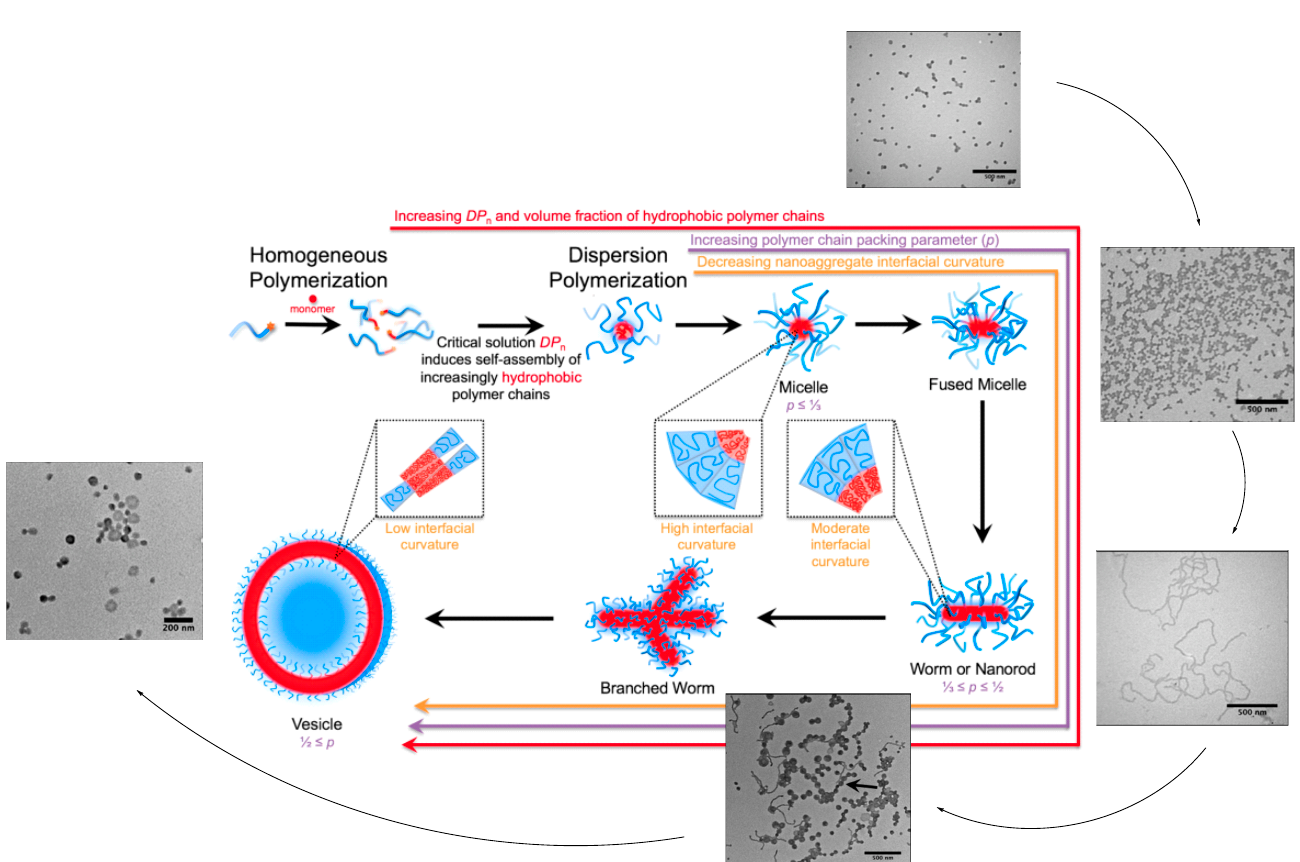
Figure 12. Polymerization-induced self-assembly process proceeding through a dispersion-based mechanism; Adapted from [188] (Copyright 2017, American Chemical Society).